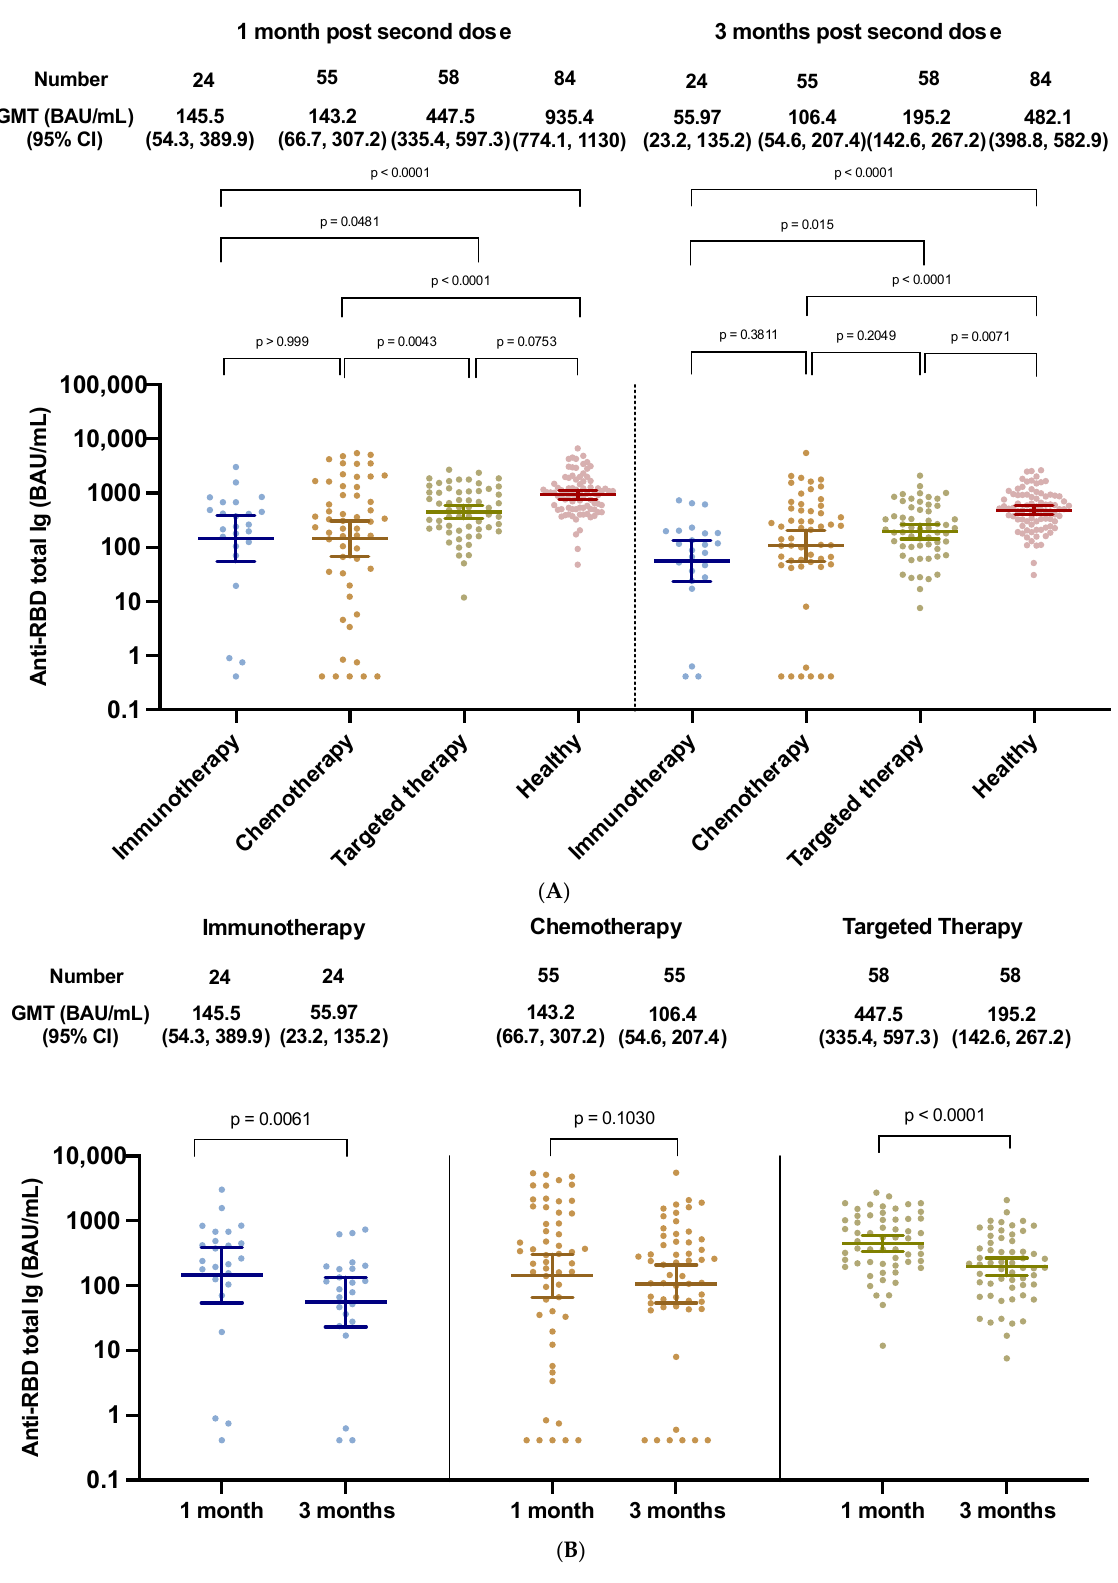
Figure 3. SARS-CoV-2 binding antibody levels at 1 and 3 months after two doses of the ChAdOx- nCoV-19 vaccine in cancer patients stratified by treatment given (n = 137) compared to healthy controls (n = 84) ( A ). GMT of Anti-RBD total Ig of SAR-CoV-2 at one month and three months after completing ChAdOx1-nCoV-19 vaccines among different types of anticancer treatments ( B ): immu- notherapy, chemotherapy, targeted therapy.